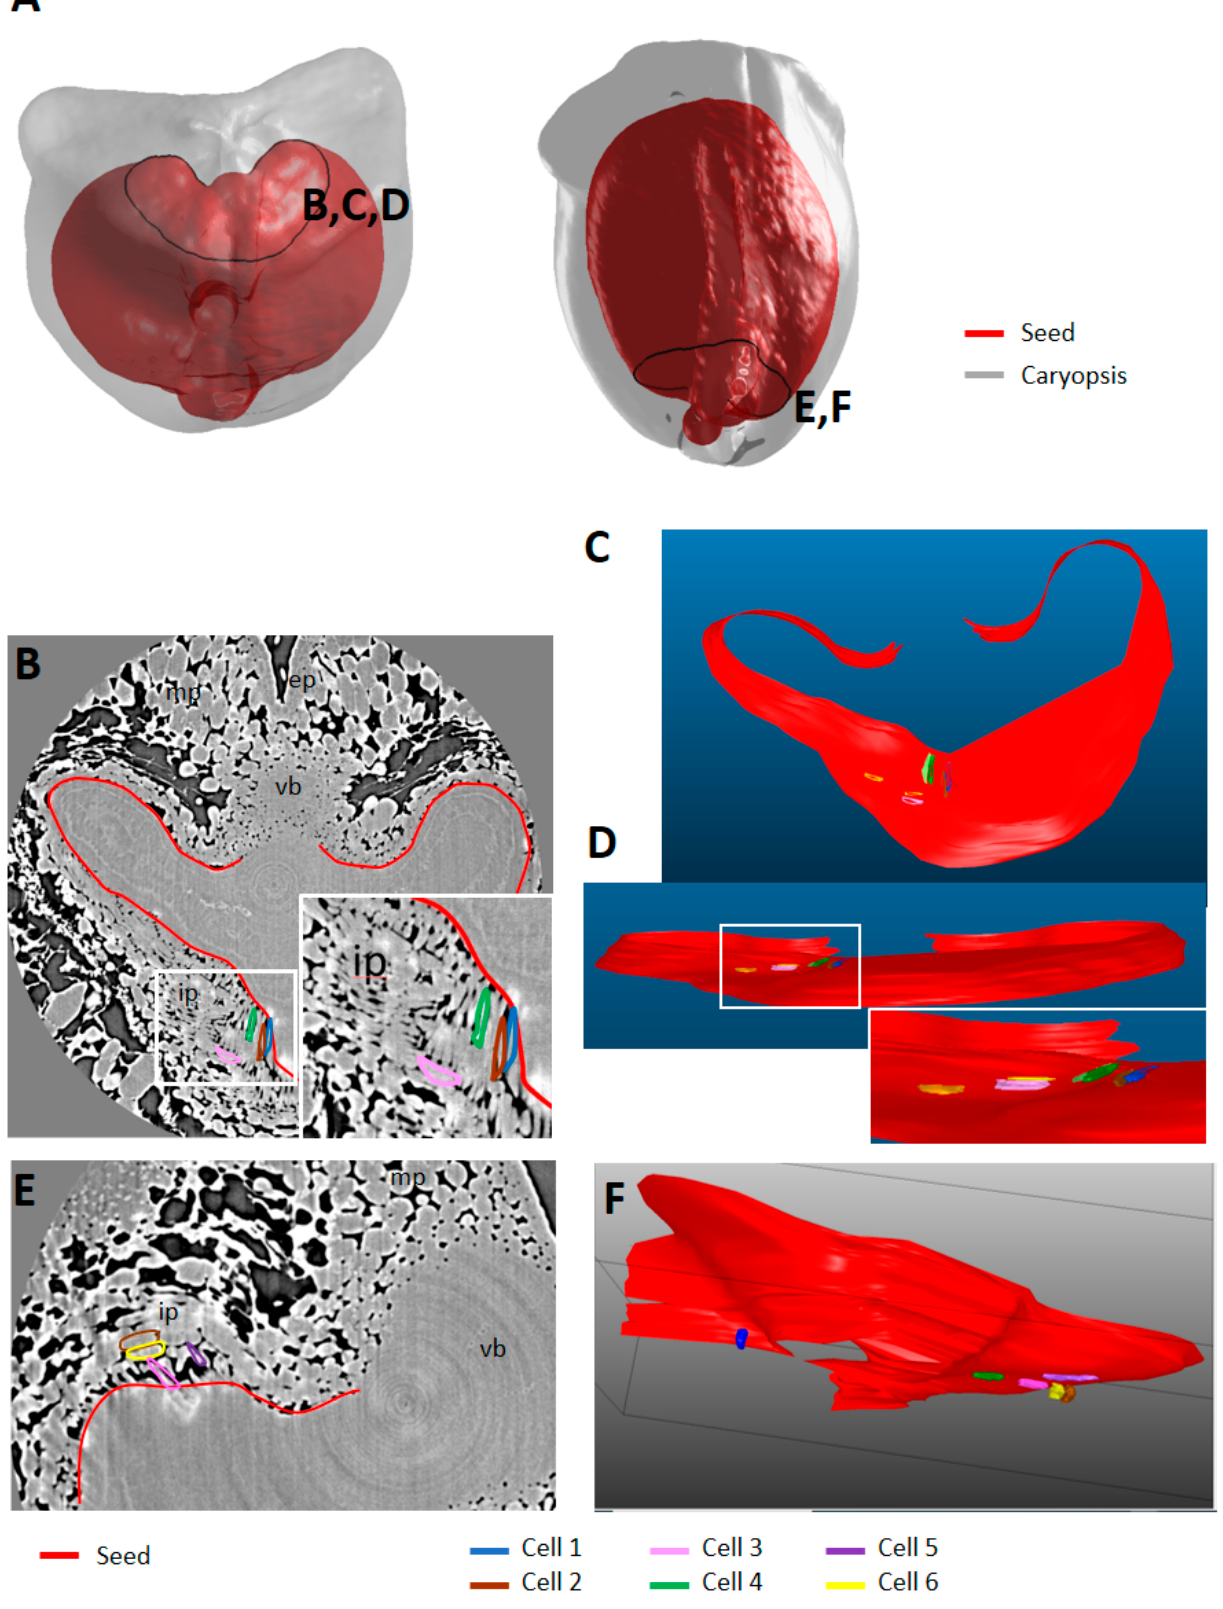
Figure 12. Endocarp cell orientation at the top and bottom of wheat caryopsis. ( A ) Localization of the region of interests (stage 150 ◦ DAA). ( B , E ) Representative high-resolution images at the top ( B